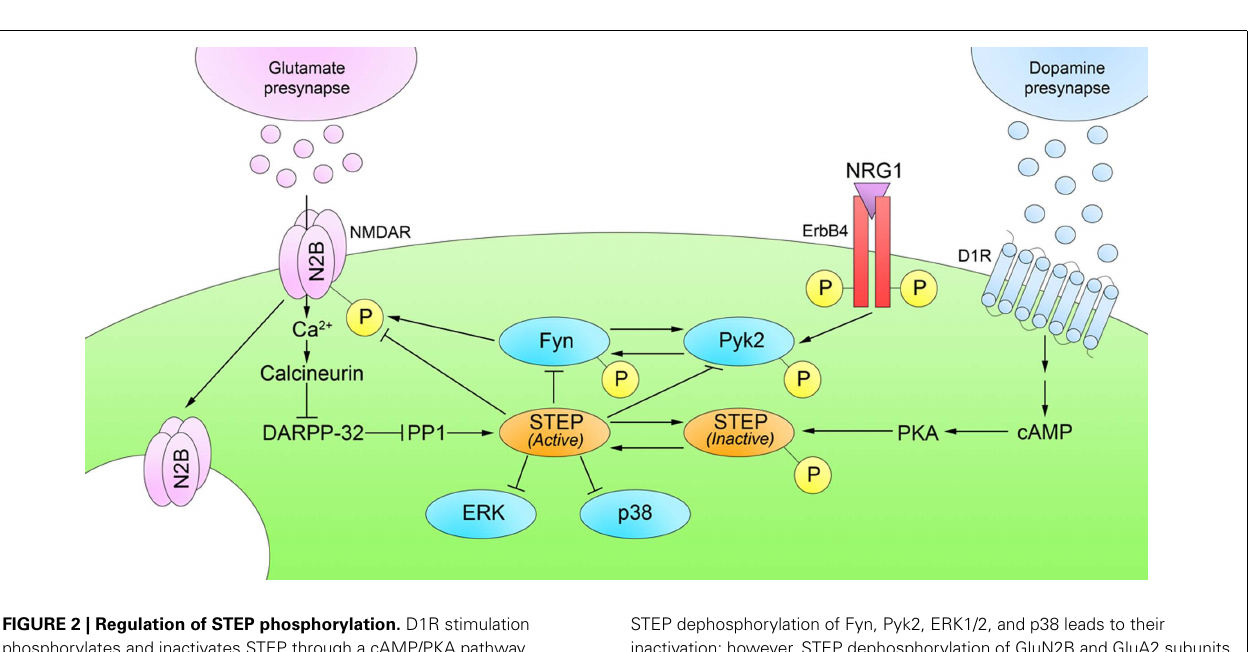
FIGURE 1 | Structure of STEP. Both STEP 46 and STEP 61 contain a kinase-interacting motif (KIM) domain, necessary for binding to all substrates, and a protein tyrosine phosphatase (PTP) domain with a catalytic site (ˆ). In addition, STEP 61 has two polyproline (PP) domains, the first of which interacts with Fyn, and two transmembrane (TM) domains that target STEP 61 to the